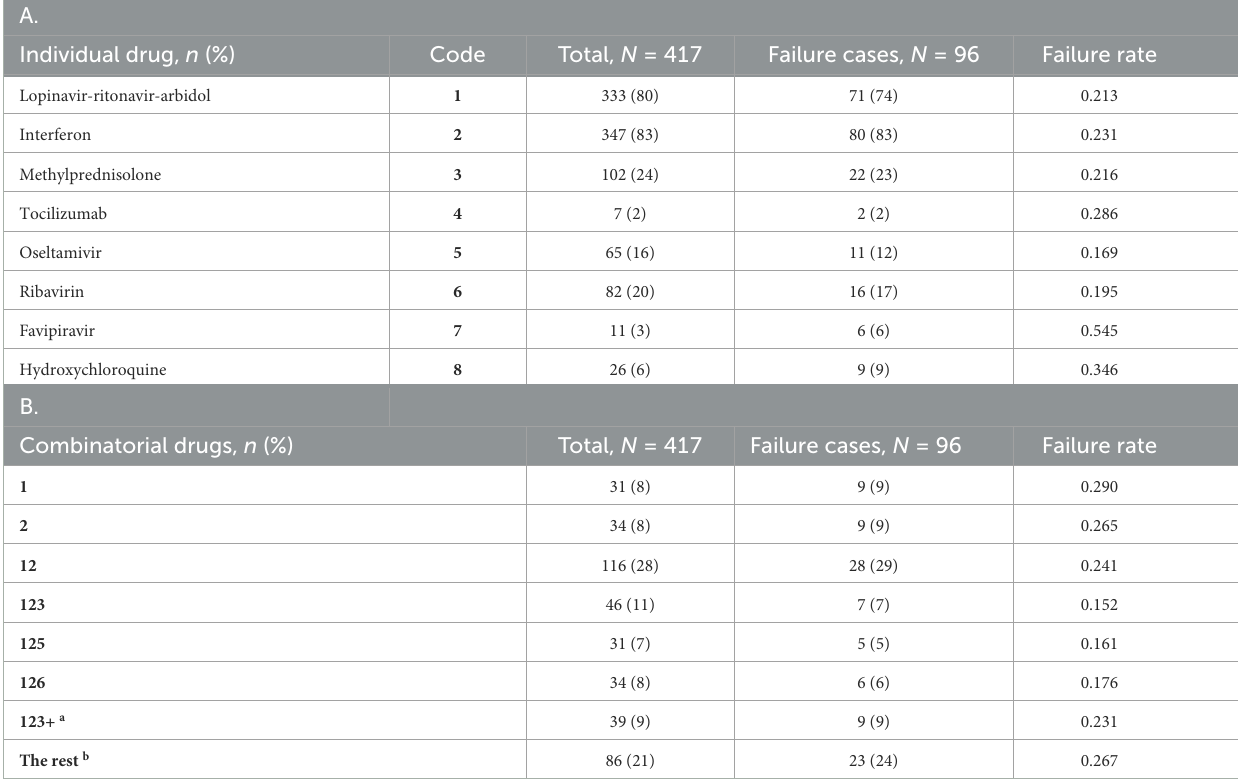
TABLE 2 Summary of individual drugs (A) and combinatorial drugs (B) adopted for the study cohort, together with related outcome information.